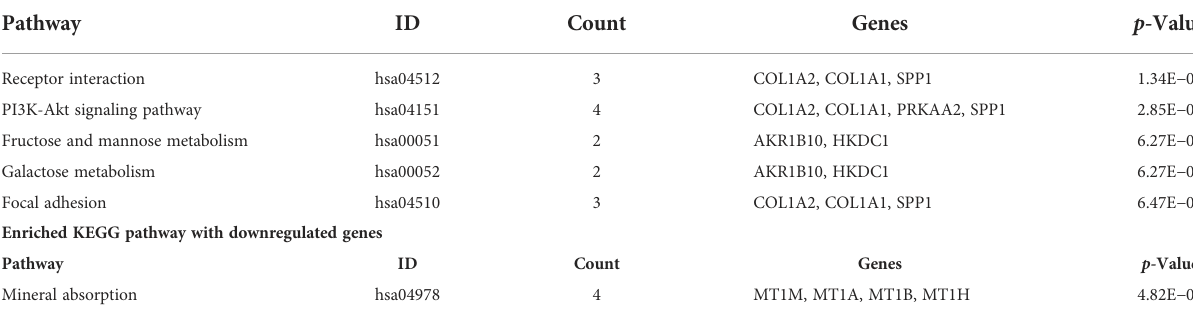
TABLE 2 KEGG analysis of integrated